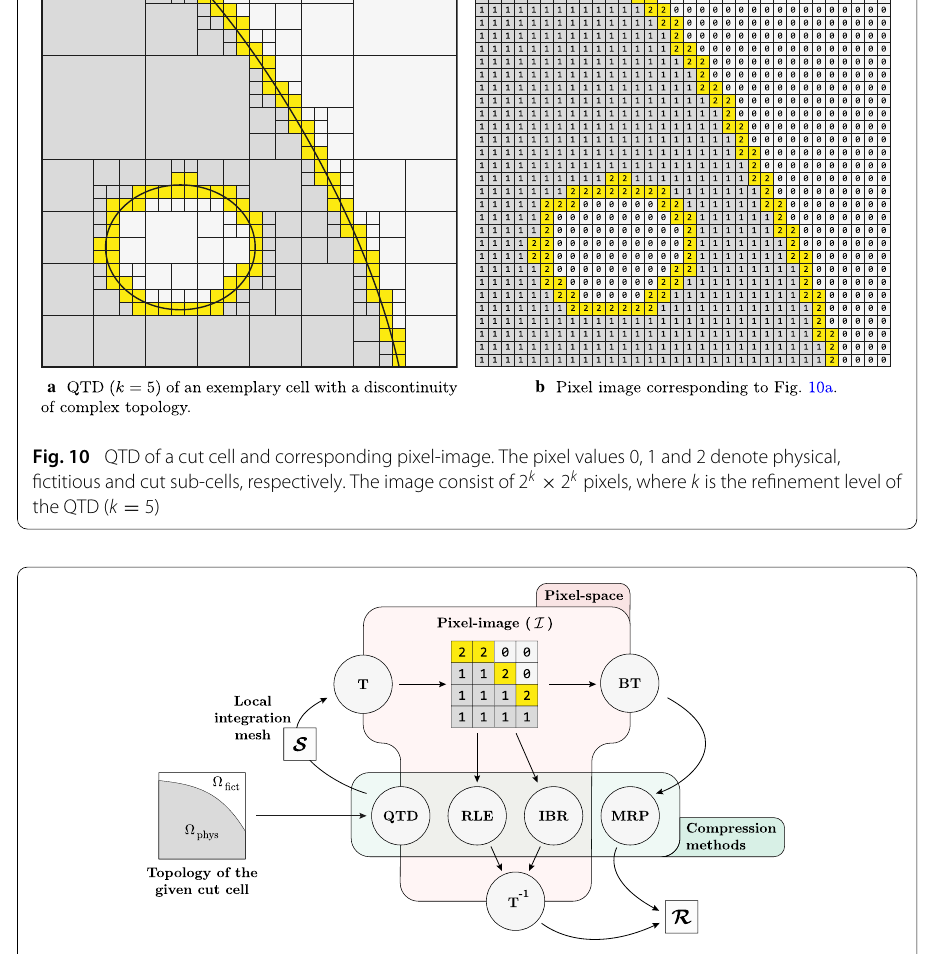
Fig. 11 Flowchart of the compression techniques applied to the integration sub-cells in the fictitious domain approach. Depending on the different image-compression techniques such as run-length encoding (RLE), image-block representation (IBR) and minimum rectangular partition (MPR), auxiliary procedures including a transformation ( T ) from the local- to the pixel-space and a boundary tracing (BT) procedure need to be introduced. The methods that are used for a transition from the local- to the pixel-space and vice versa are indicated at the boundary marking the pixel-space. Note that the QTD is also essentially an image-compression technique, thus it can operate both in the pixel- and local-space. Therefore, it is also located on the